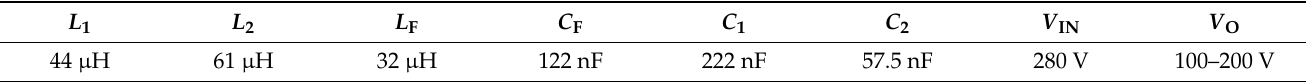
( d ) Figure 8. Measured waveforms of inverter and rectifier: ( a ) 𝑉 (cid:2899) = 100 V,𝑘 = 0.16 ; ( b ) 𝑉 (cid:2899) = 200 V,𝑘 = 0.16 ; ( c ) 𝑉 (cid:2899) = 100 V, 𝑘 = 0.23 ; ( d ) 𝑉 (cid:2899) = 200 V,𝑘 = 0.23 . ( a ) ( b ) Figure 9. Measured waveforms: ( a ) transient response and ( b ) soft-switching.